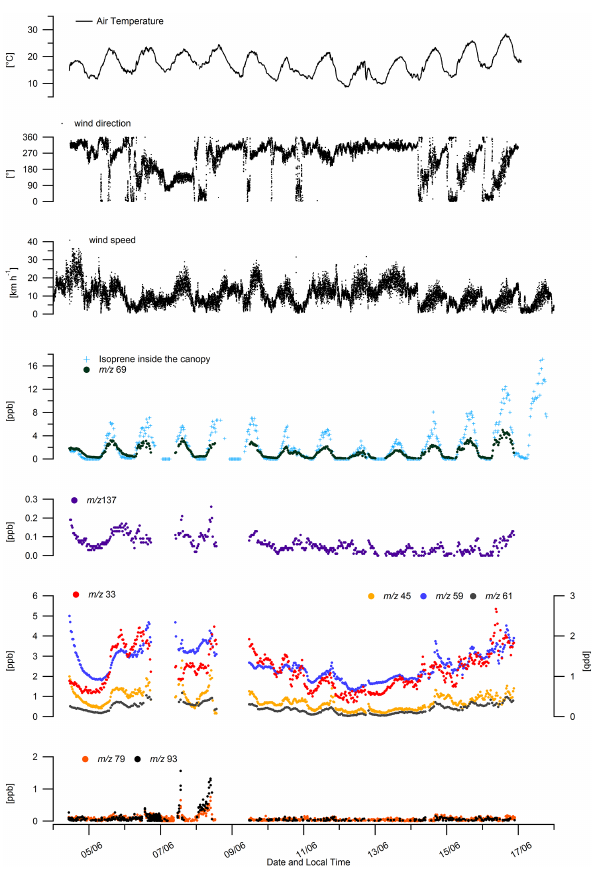
Figure 3. Time series of VOCs and meteorological parameters recorded from 4 to 16 June. Benzene ( m/z 79), toluene ( m/z 93), methanol ( m/z 33), acetaldehyde ( m/z 45), acetone ( m/z 59), sum of acetic acid and glycolaldehyde ( m/z 61), total monoterpenes ( m/z 137) and isoprene ( m/z 69) were measured by PTR-MS above the canopy along with temperature and wind direction. Isoprene in- side the canopy (2ma.g.l) was measured by online GC-FID from 4 to 17 June. Table 3. Quality assessment of isoprene, methanol and MVK + MACR fluxes. Isoprene Methanol MVK + MACR